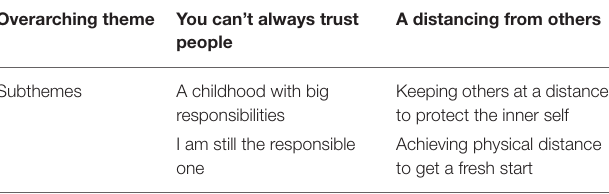
TABLE 1 | Overarching themes of responsibility and distancing. Overarching theme You can’t always trust